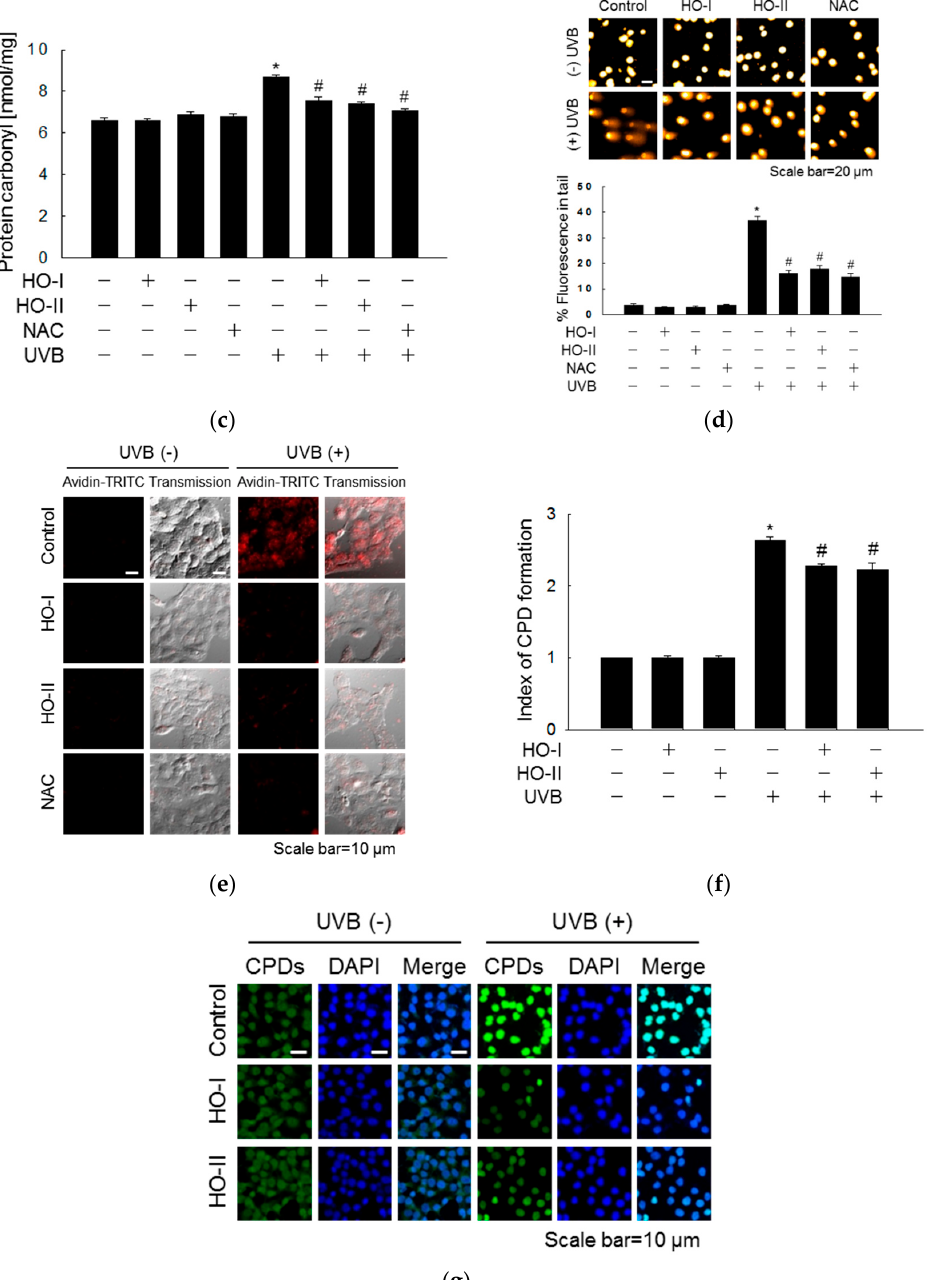
Figure 2. Horse oil mitigates UVB-induced oxidative damage to cellular macromolecules. Cells were treated with horse oil or NAC for 1 h and then exposed to UVB radiation. After incubation, lipid peroxidation was assayed by measuring ( a ) the levels of 8-isoprostane secreted into the culture medium or ( b ) DPPP-stained cells were detected by confocal microscopy and quantified (Scale bar=10 μ m). ( c ) Protein oxidation was assayed by measuring protein carbonylation. ( d ) DNA damage was assessed by the comet assay. Representative images and the percentage of total cellular DNA in comet tails are shown (Scale bar=10 μ m). * p < 0.05 vs. control, and # p < 0.05 vs. UVB-irradiated cells. ( e ) 8-OxoG detected by the binding of avidin-TRITC was visualized by confocal microscopy (Scale bar=10 μ m). DNA was extracted and analyzed by ( f ) ELISA and ( g ) immunocytochemistry using an antibody against CPDs. DAPI was used to stain the nuclei (Scale bar = 10 μ m). * p < 0.05 vs. control, and # p < 0.05 vs. UVB-irradiated cells.